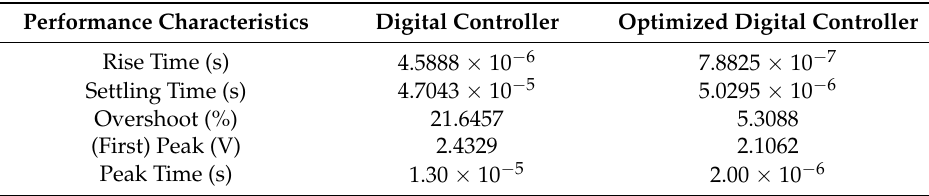
Table 4. Comparison of performance characteristics.